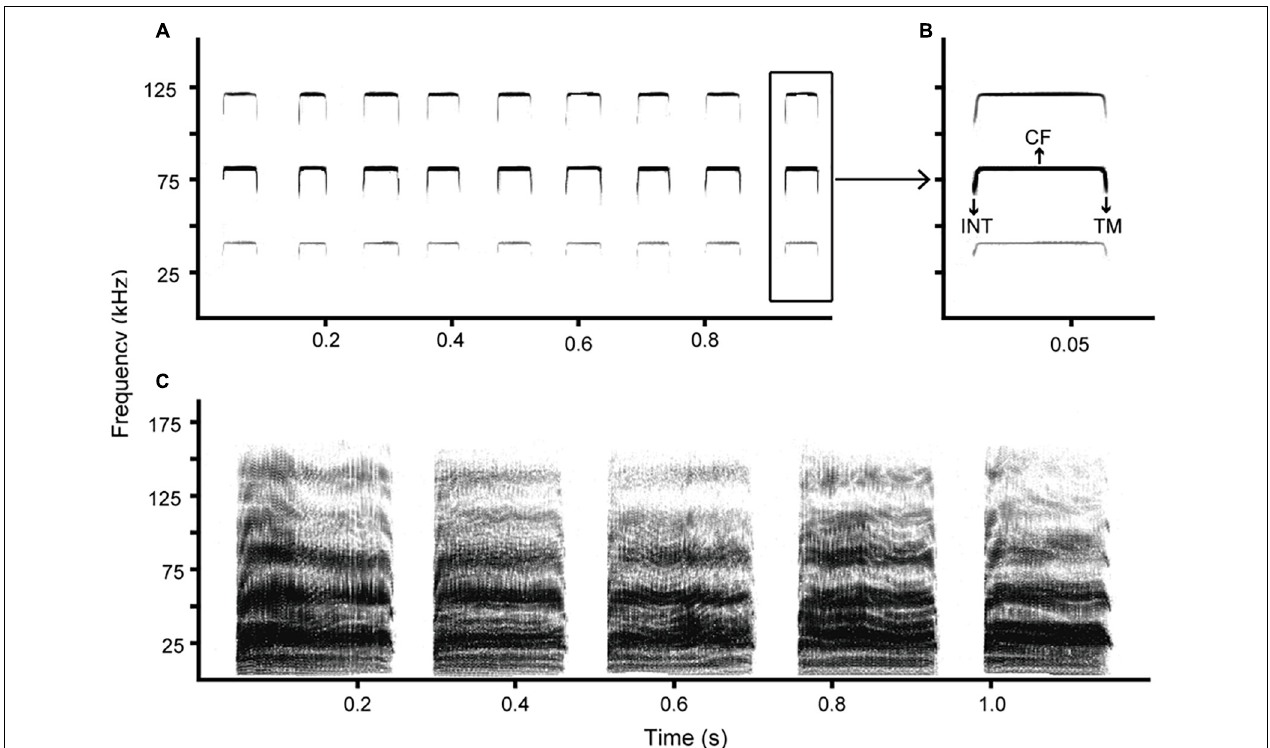
FIGURE 1 | Spectrograms of echolocation pulses (A,B) and distress calls (C) emitted by R. sinicus . Distress call sequences of R. sinicus are composed of mainly broadband noise burst syllables (Huang et al., 2018). CF, constant frequency component; INT, initial frequency modulated component; TM, terminal frequency modulated